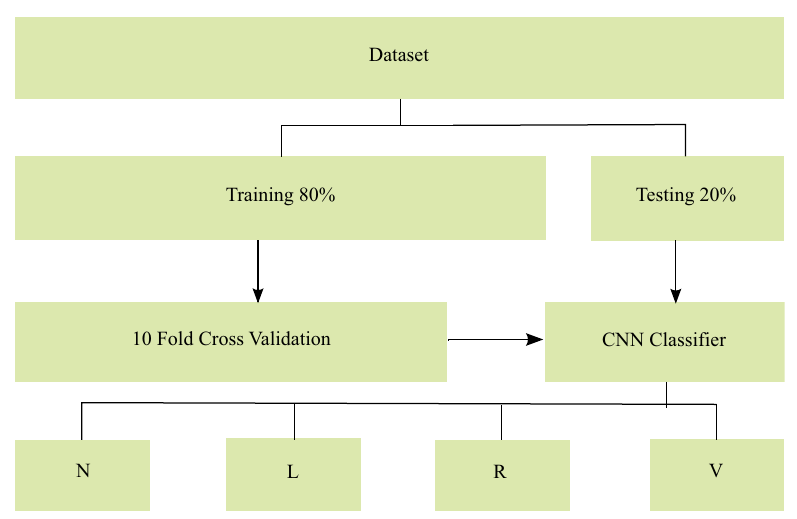
Figure 2: The train - test split and the data fl ow through the proposed